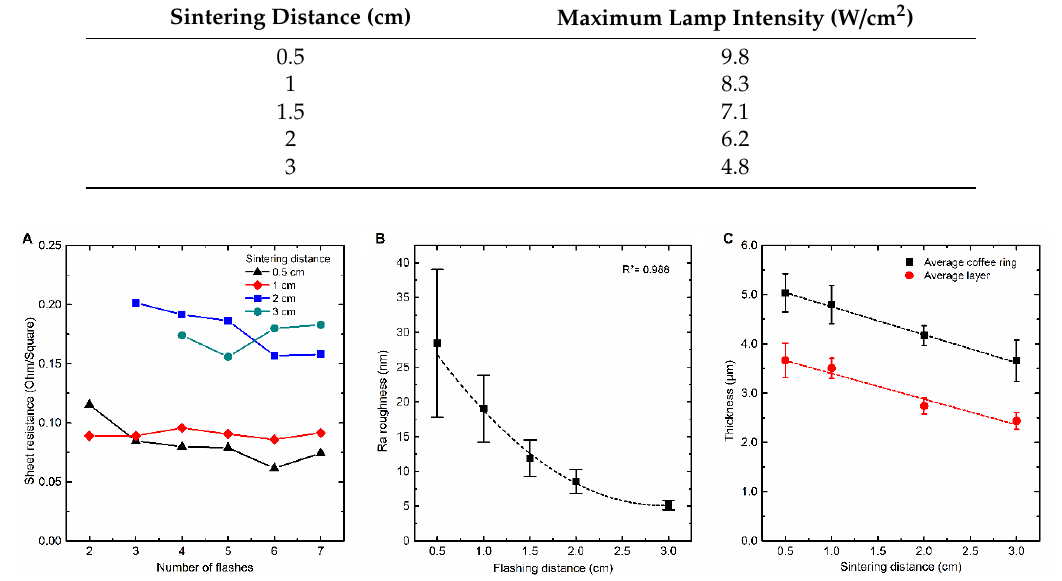
Figure 8. Sintering at shorter distances results in lower sheet resistance and requires a smaller number of flashes. ( A ) The higher light intensity at shorter distances causes a higher surface roughness, it exponentially decreases with increasing sintering distance according to the decrease of light intensity of Table 1 (Every datapoint consists out of three corresponding samples with every sample measured on two locations with the profilometer (line measurement), the error bars represent the standard deviation of each population.). ( B ) The layer thickness decreases linearly when increasing the sintering distance for JS-A102A at a flashing intensity of 100% and a flash and cooling time of 2 s (Each data point is representing the average of 8 to 12 measurements distributed over four to six different samples. The error bars represent the standard deviation of each population.).( C )